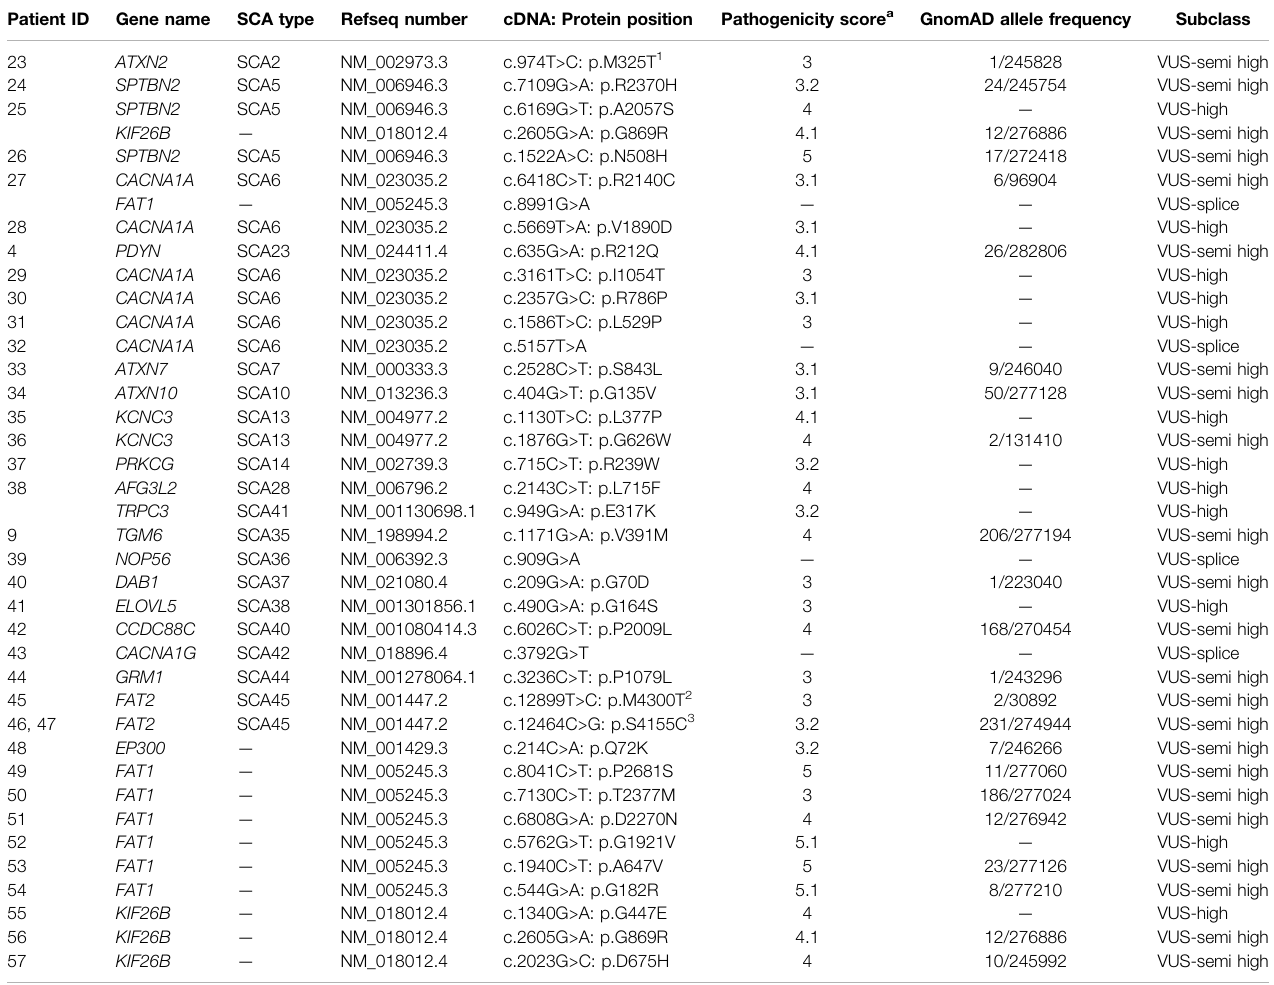
TABLE 3 | List of VUS-semi high, VUS-high and VUS-splice identi fi ed in 36 patients. Patient